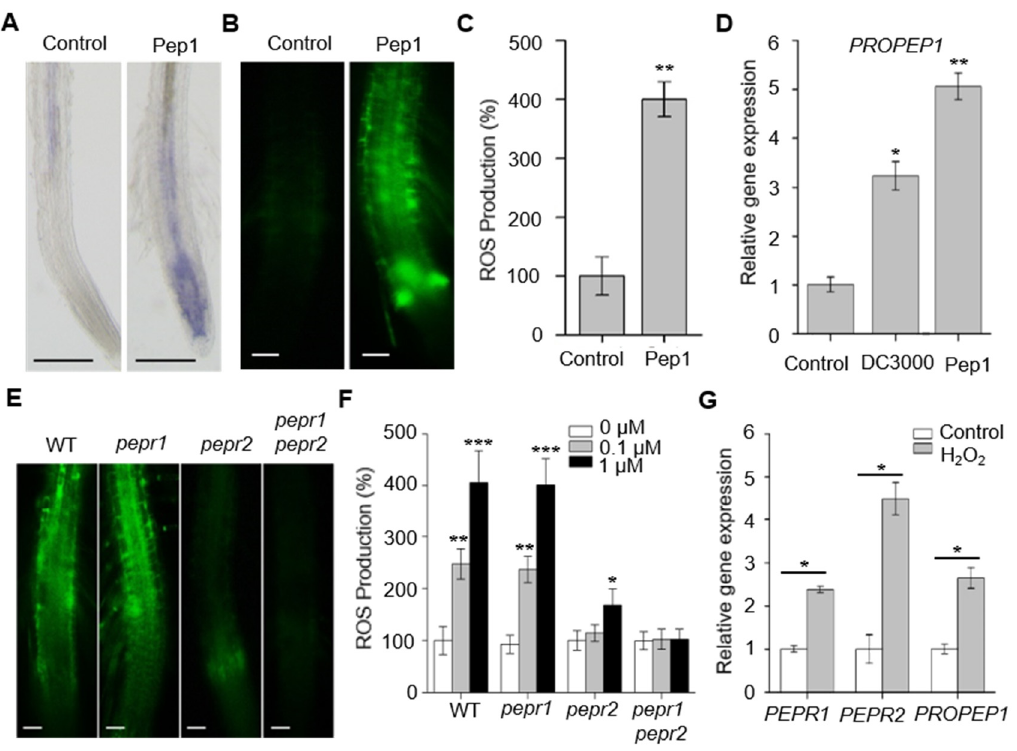
Figure 2. Pep1-PEPRs system activates the ROS signaling in root. ( A ) NBT staining of superoxide (O 2 − ) anion in wild type (WT) roots. Six-day-old seedlings were incubated in half-strength MS liquid medium with or without (Control) 1 µ M Pep1 for 18 h, the roots were stained with 1 mM NBT solution for 60 min and photographed under microscopy. Bars = 200 µ m. ( B ) H 2 DCF-DA staining of H 2 O 2 in WT roots. Six-day-old seedlings were incubated in half-strength MS liquid medium with or without (Control) 1 µ M Pep1 for 18 h, the roots were stained with 30 µ M H 2 DCF-DA solution for 10 min and photographed under fluorescence microscopy (Olympus, BX53). Bars = 100 µ m. ( C ) The statistical analysis of ROS production in ( B ). Data are means ± SD from three independent experiments. ( n = 24). ( D ) Quantitative RT-PCR analysis of mRNA levels of PROPEP1 in the wild type roots treated with or without (Control) DC3000 solution (initial OD 600 of 0.02) or 1 µ M Pep1 for 4h, respectively. The expression level of control was set as 1.0. Data are means ± SD ( n = 3). ( E ) H 2 DCF-DA staining of H 2 O 2 in WT, pepr1 , pepr2 and pepr1 pepr2 roots. Six-day-old seedlings were incubated in half-strength MS liquid medium supplemented with 1 µ M Pep1 for 18 h, the roots were stained with 30 µ M H 2 DCF-DA solution for 10 min and photographed under fluorescence microscopy (Olympus, BX53). Bars = 100 µ m. ( F )